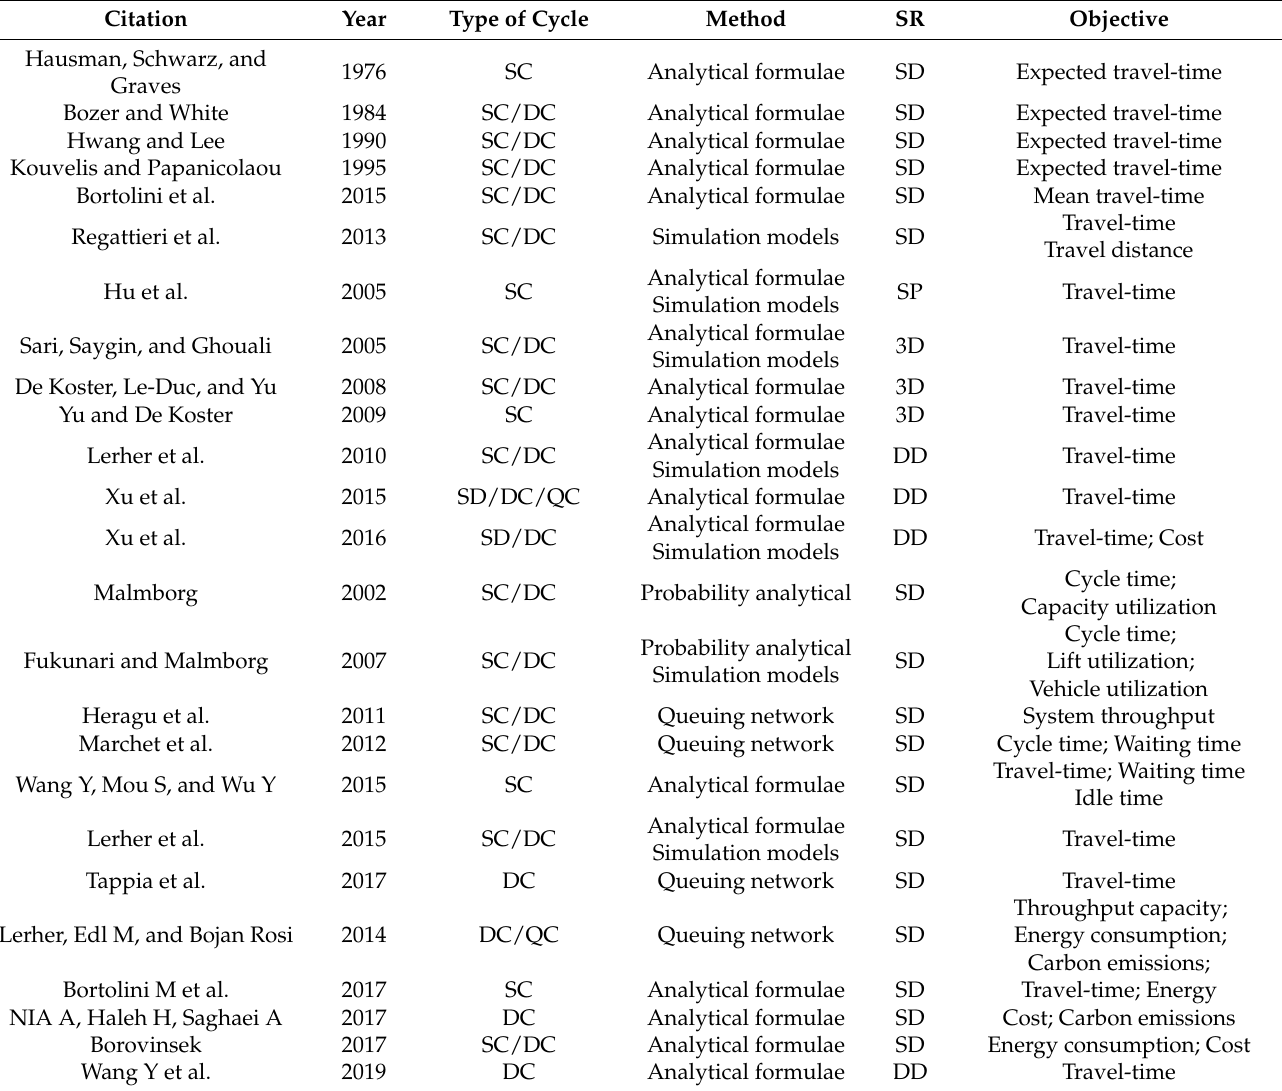
Table 1. A summary of